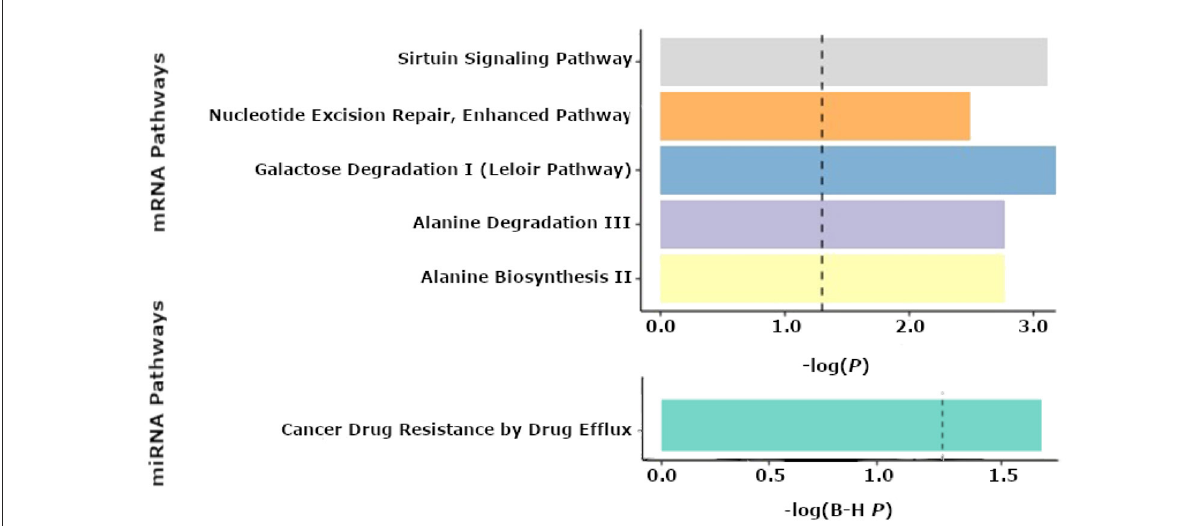
FIGURE4 Pathway enrichment analyses from the Qiagen IPA tool. Results of enriched pathways from mRNAs when nominal P -values from the logistic regression testing for associations between mRNA and seizure outcome were filtered with a P < 0.05 threshold for all mRNAs prior to submitting mRNAs for pathway analysis in IPA. The x -axis shown represents –log( P -values), with a cutoff of 1.3 denoting a P < 0.05. The top 5 pathways are shown for mRNAs from tissue (top panel). Enriched microRNA (miRNA) pathways after nominal p -values from the logistic regression of miRNAs and seizure outcome were filtered with a P < 0.05 threshold prior to performing pathway analyses using IPA (bottom panel). The x -axis shown represents -log(FDR corrected P -values), with a cutoff of 1.3 representing a P <